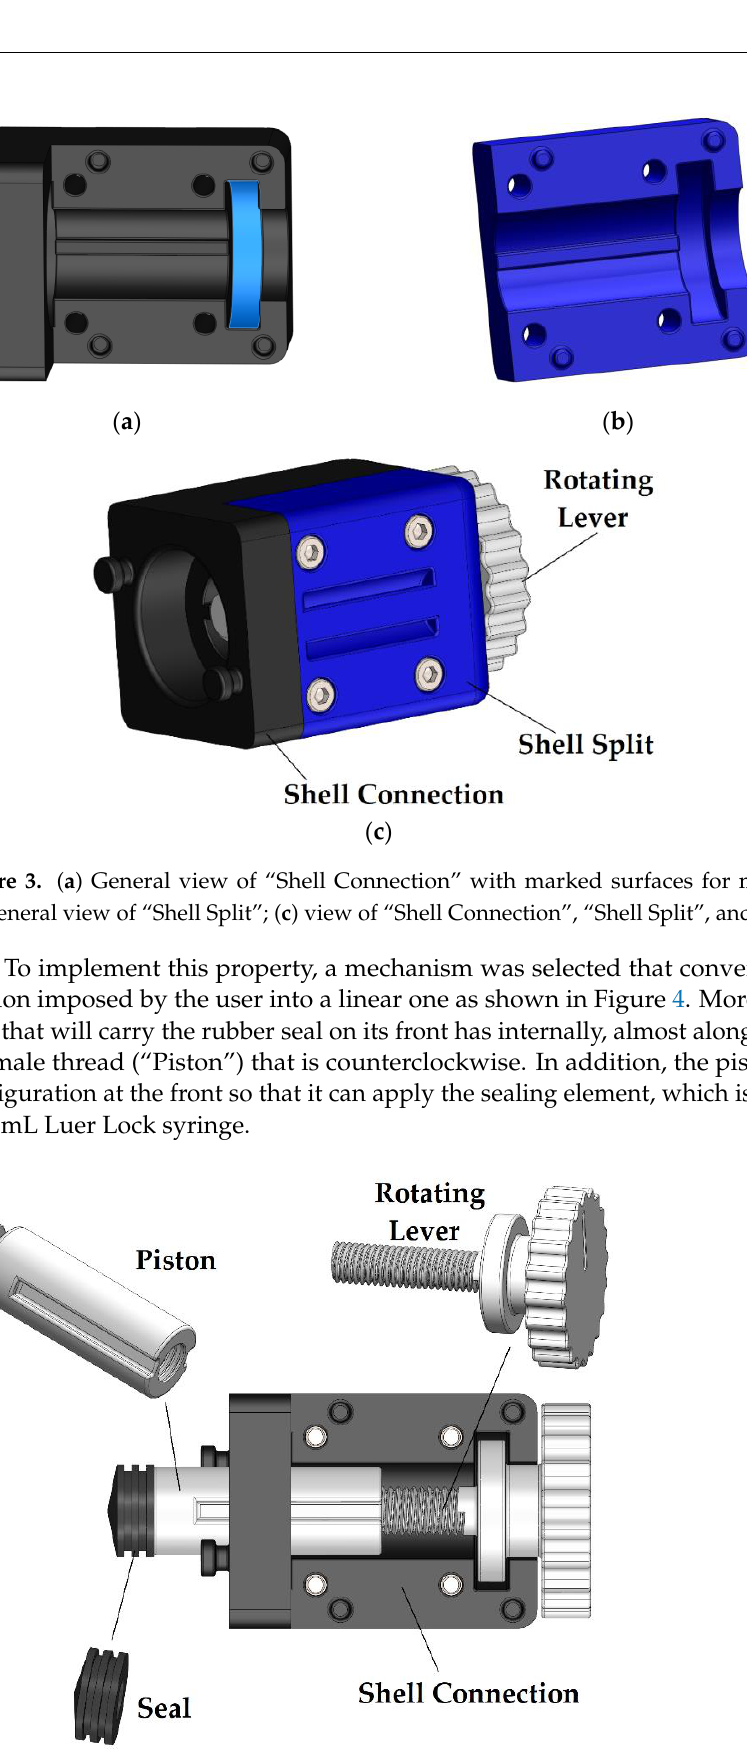
Figure 4. Internal view of sub-assembly B.